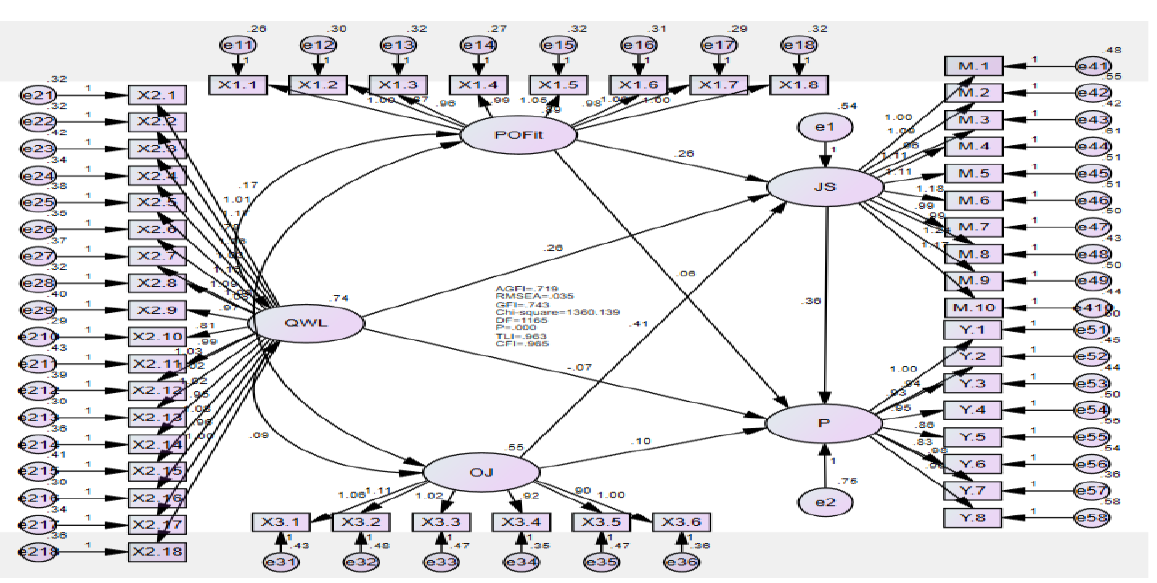
Figure 2: SEM structural diagram